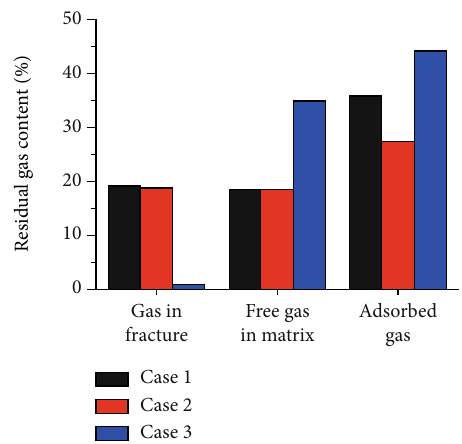
Figure 16: The residual gas content in di ff erent systems of coal for the three cases after twenty-year